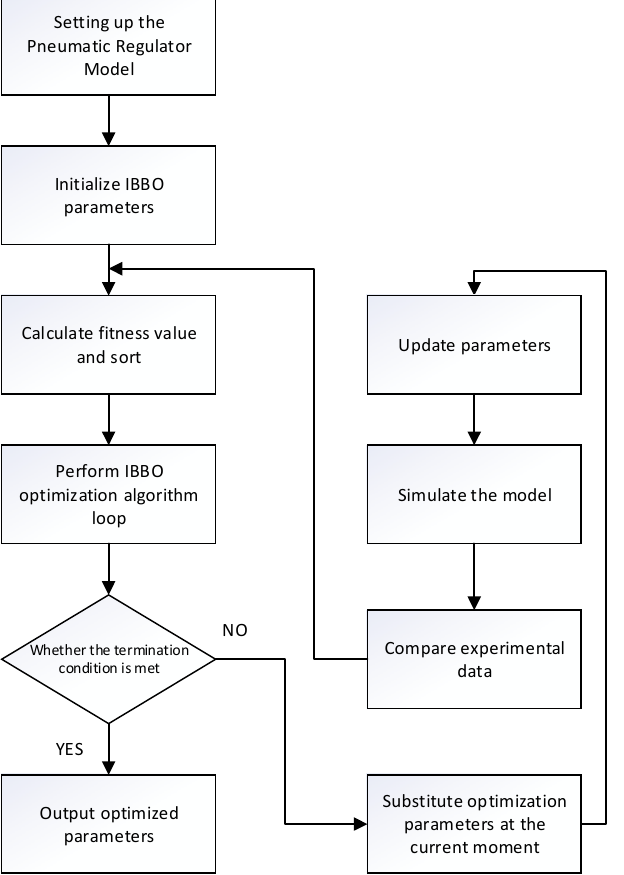
Figure 9. Improved biogeography-based optimization algorithm identification model flow chart.